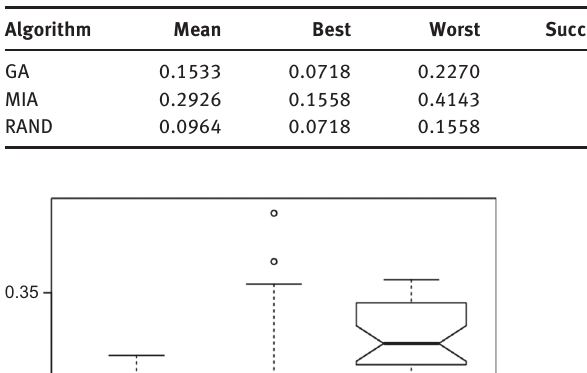
Table 1. Length 13 2 PSK